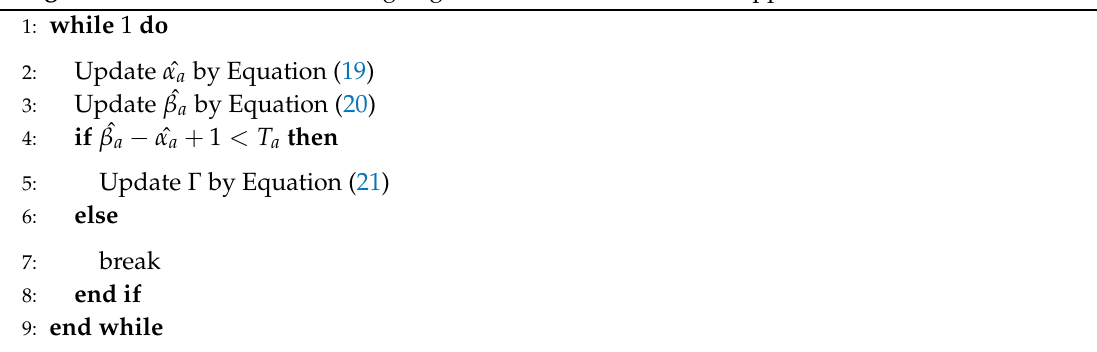
Algorithm 3: Preference Searching Algorithm for Uncontrollable